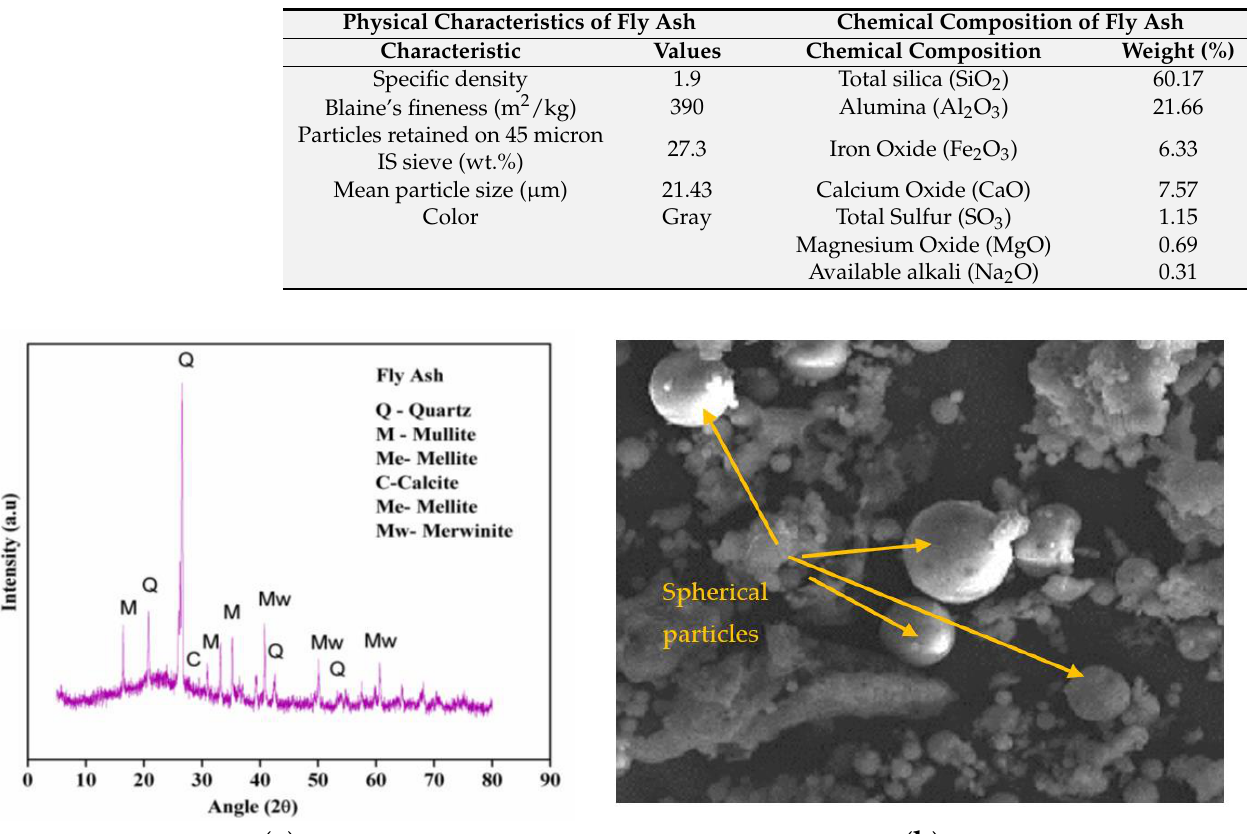
Figure 1. XRD spectrum and SEM image of fly ash. ( a ) XRD spectrum of fly ash; ( b ) SEM image of fly ash.